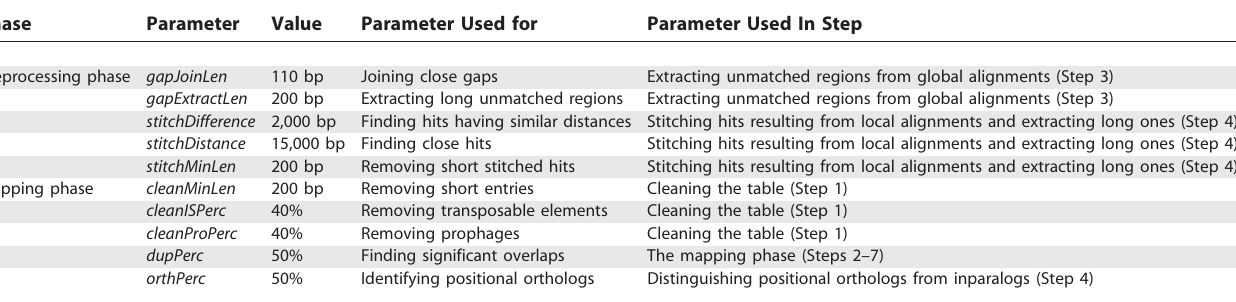
Table 1. A Summary of the Parameters Used in MAGIC